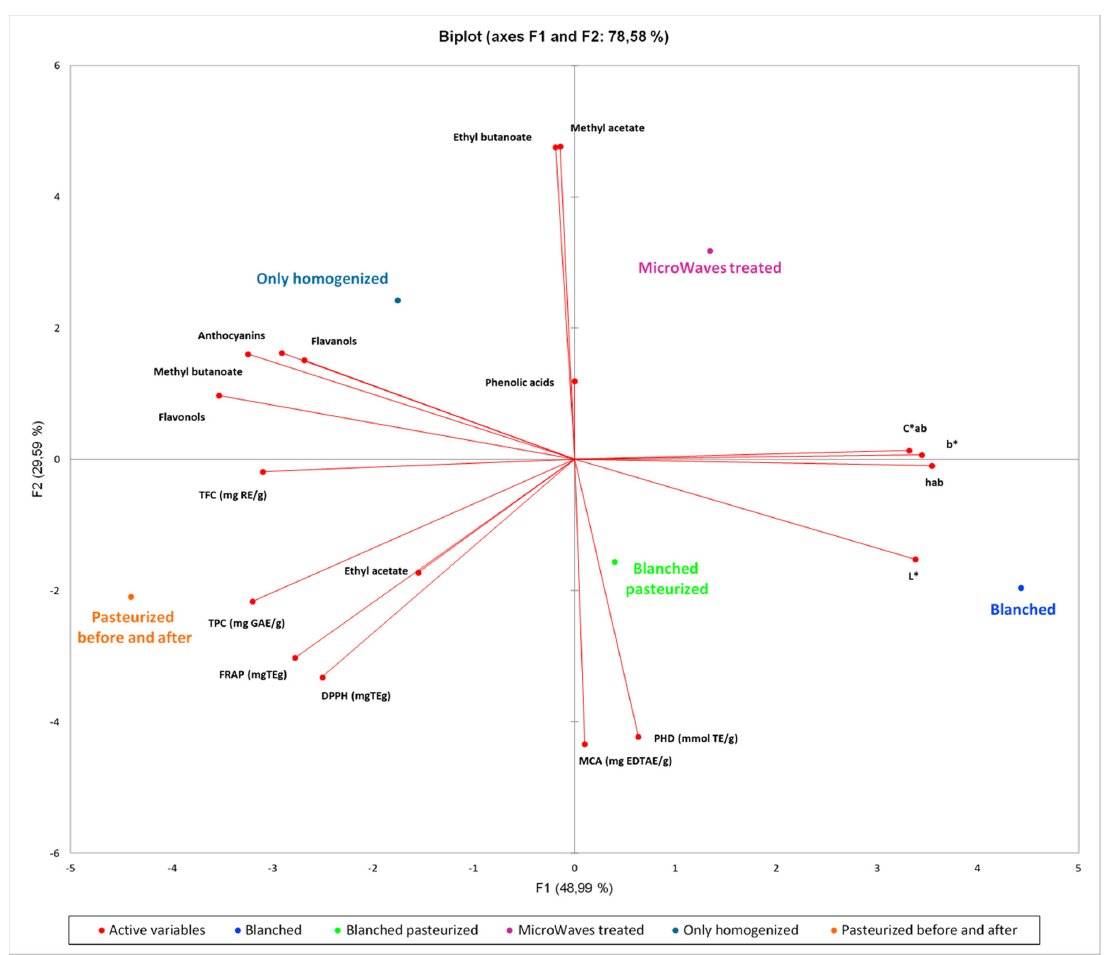
Figure 5. Principal component analysis (PCA) plots of the fresh analyzed samples evaluated as series.